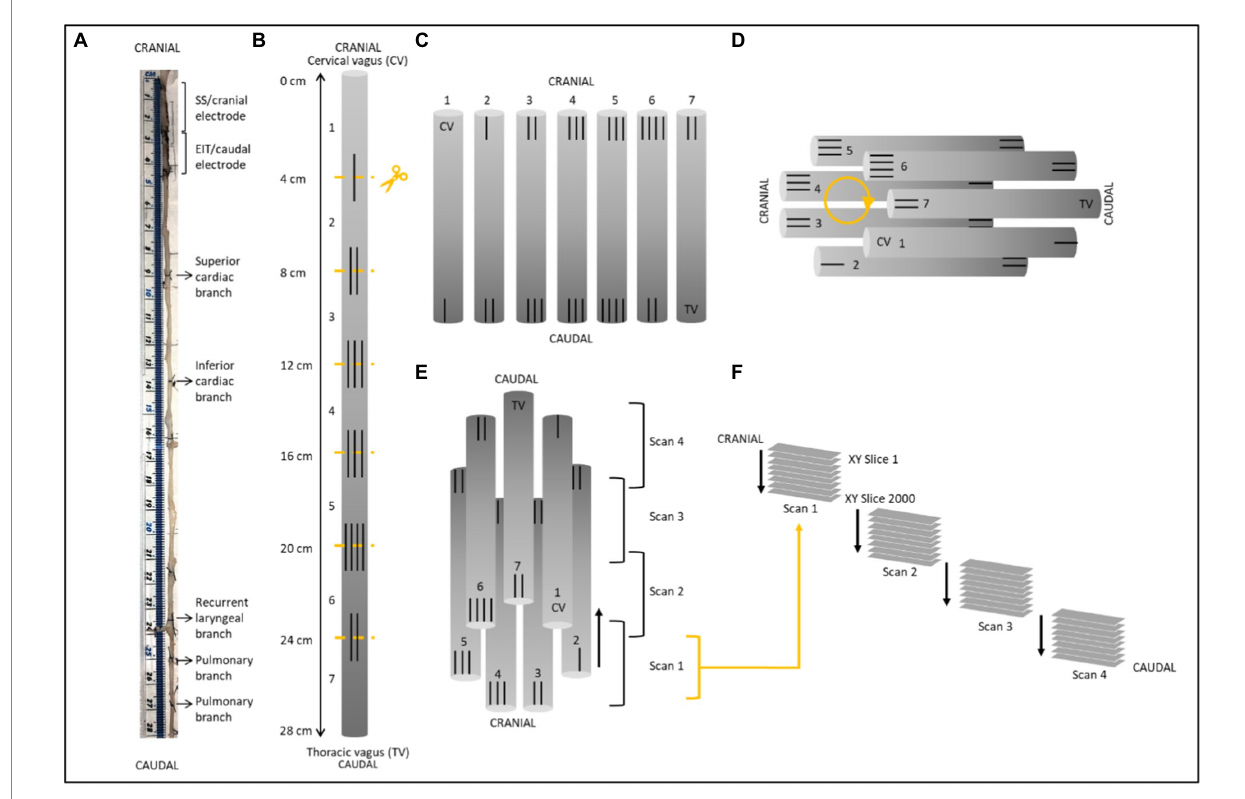
FIGURE 3 Schematic of nerve preparation. (A) Photo of a nerve with sutures tied around the vagal trunk proximal to the branching region and demarcating ends of the two electrode cuffs. Each nerve was approximately 28 cm in length. (B) Sutures were superglued into place every 4 cm along the length of the nerve with varying numbers to allow for identification of the sections and alignment during segmentation. Sections were cut at the middle of the markers. (C) After contrast staining, nerve sections were ordered from first to last [cervical (CV) to thoracic vagus (TV)], with cranial sides aligned, into cling film and sealed. (D) The sealed nerve sections were rolled around a cylindrical sponge in a clockwise order and wrapped in more cling film to maintain its shape. (E) The cylinder of nerve samples was placed upside down (cranial side down) into a 3D printed mount and placed in the scanner. Each scan was 1.42 cm in length with an overlapping region of 1.4 mm. (F) This setup allowed for the overlapping scans to follow on from another consecutively in the correct order from cranial to caudal along the whole vagus nerve. One nerve is shown here; however, the same preparation was used for all four